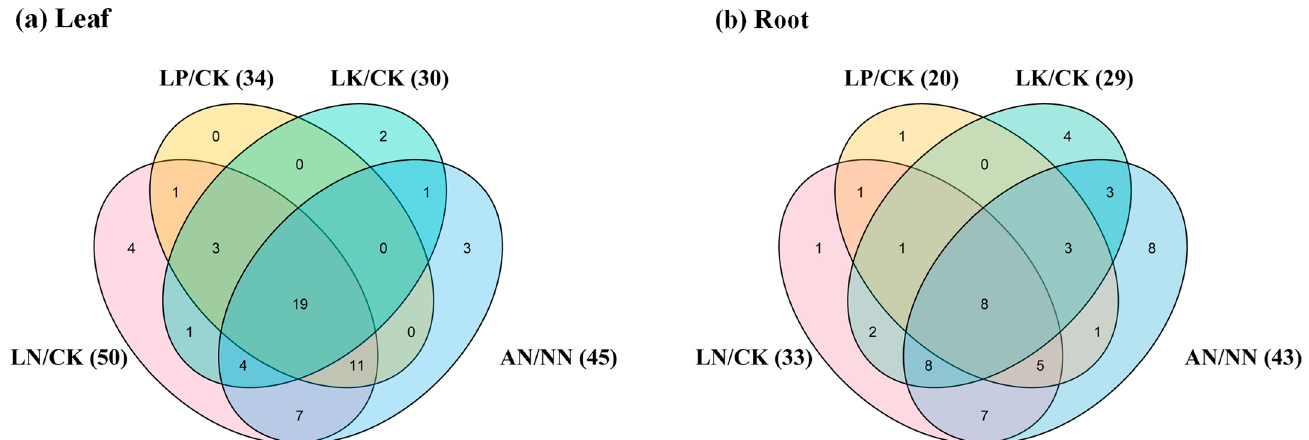
Figure 7. Venn diagram showing the transcriptional responses of the nitrogen assimilation-related genes in the leaf ( a ) and root ( b ) of Brassica napus under diverse nutrient deficiencies. Each color represents different treatment, and the number in brackets represents the differentially expressed genes between control and the corresponding treatment. CK, control; LN, nitrogen free condition; LP, phosphorus free condition; LK, potassium free condition; NN, nitrate-fed only; AN, ammonium-fed only.